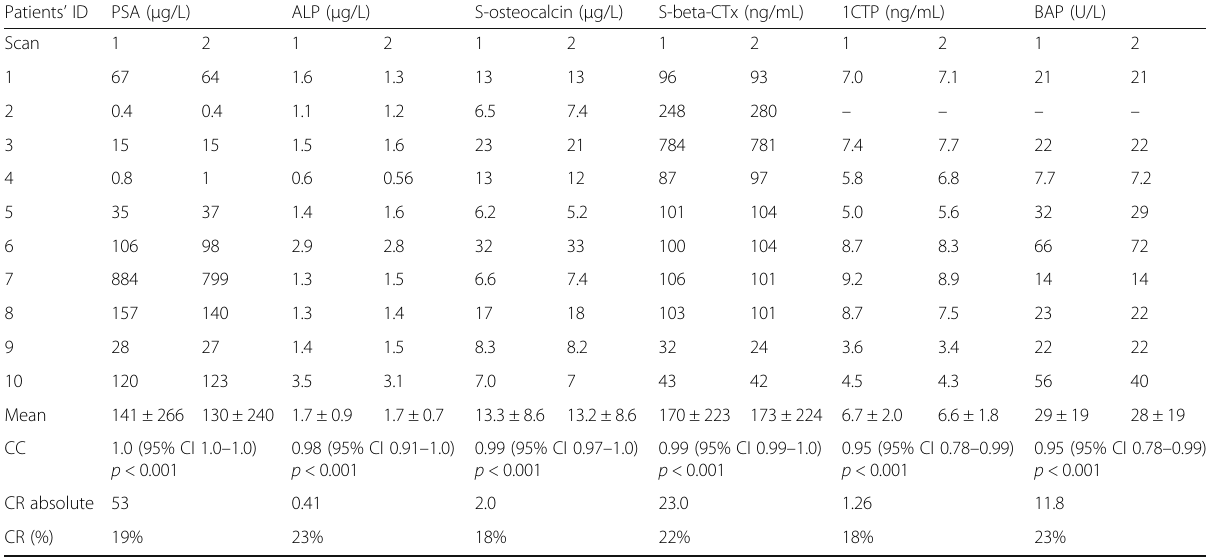
Table 3 Repeatability of PSA and biochemical bone turnover markers Patients ’ ID PSA ( μ